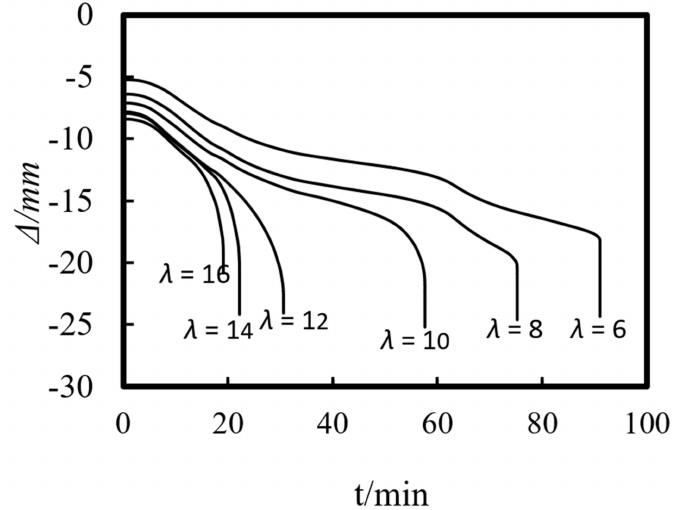
Figure 16. Effect of slenderness ratio on the axial deformation–time curve.